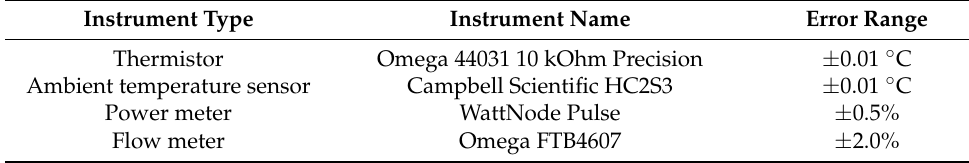
Table 2. Measurement devices.